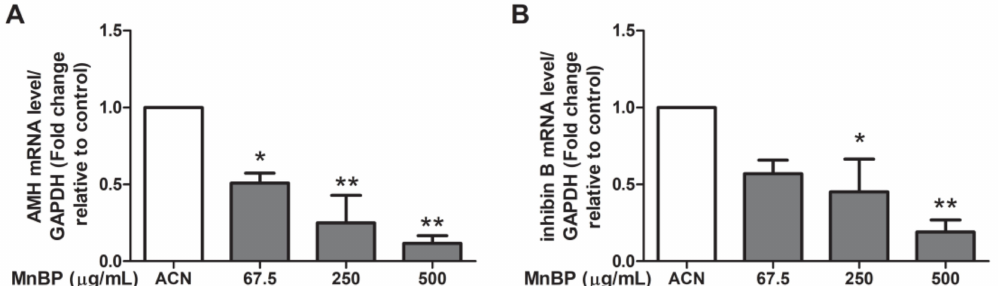
Figure 5. E ff ects of MnBP on the expression of ( A ) AMH and ( B ) inhibin B in human granulosa cells. The expression levels of mRNA for the AMH and inhibin B was measured using the reverse transcription quantitative polymerase chain reaction. Human granulosa cells were seeded overnight and treated with solvent control (ACN) and 67.5, 250, or 500 µ g / mL of MnBP for 24 h. The expression levels of AMH and inhibin B were normalized to that of GAPDH. Data are shown as mean ± SD compared to those of the solvent control. * p < 0.05. ** p <